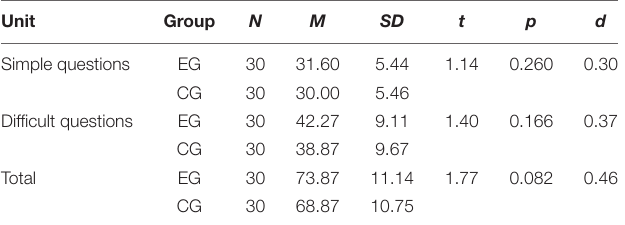
TABLE 10 | The independent sample t -test of the two groups’ Bebras